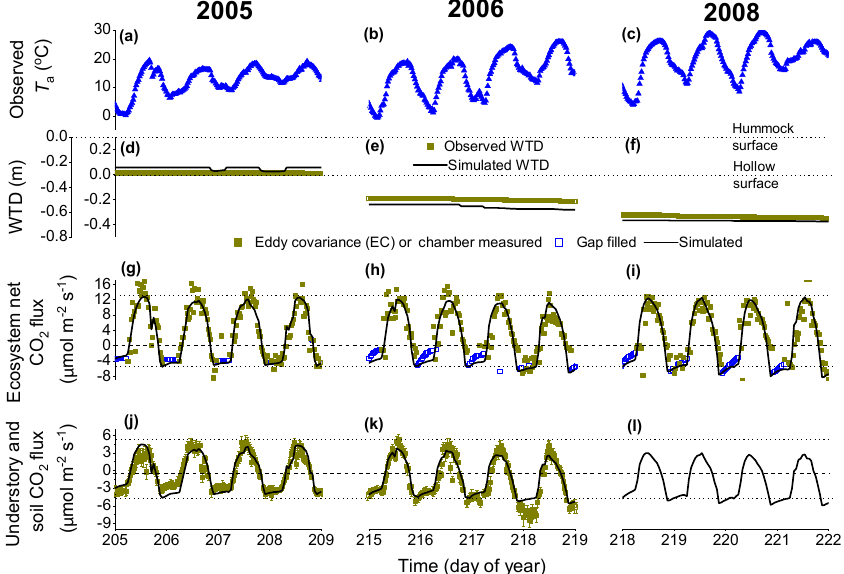
Figure 6. (a–c) Half-hourly observed T a ; (d–f) hourly modeled and half-hourly observed (Syed et al., 2006; Cai et al., 2010; Long et al., 2010; Flanagan and Syed, 2011) WTD; (g–i) half-hourly EC-measured and gap-filled (Flanagan and Syed, 2011) and hourly modeled ecosystem net CO 2 fluxes; (j–l) half-hourly automated chamber-measured (Cai et al., 2010) and hourly modeled understory and soil CO 2 fluxes during July–August of 2005, 2006 and 2008 at a western Canadian fen peatland. No chamber CO 2 flux measurement was available for 2008. Bars represent standard errors of means of chamber CO 2 fluxes ( n = 9). A negative flux represents an upward flux or a flux out of the ecosystem, and a positive flux represents a downward flux or a flux into the ecosystem. A negative WTD represents a depth below hummock/hollow surface, and a positive WTD represents a depth above hummock/hollow